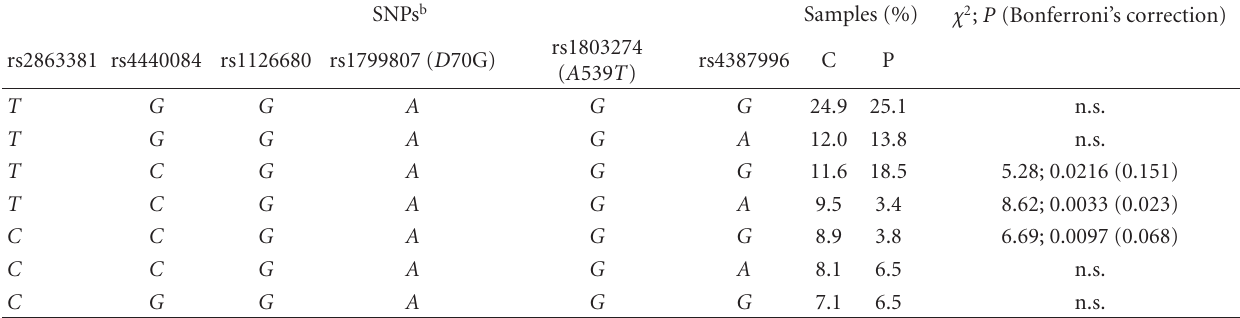
Table 3: Haplotype a frequencies compared between contact control (C) and patient (P)